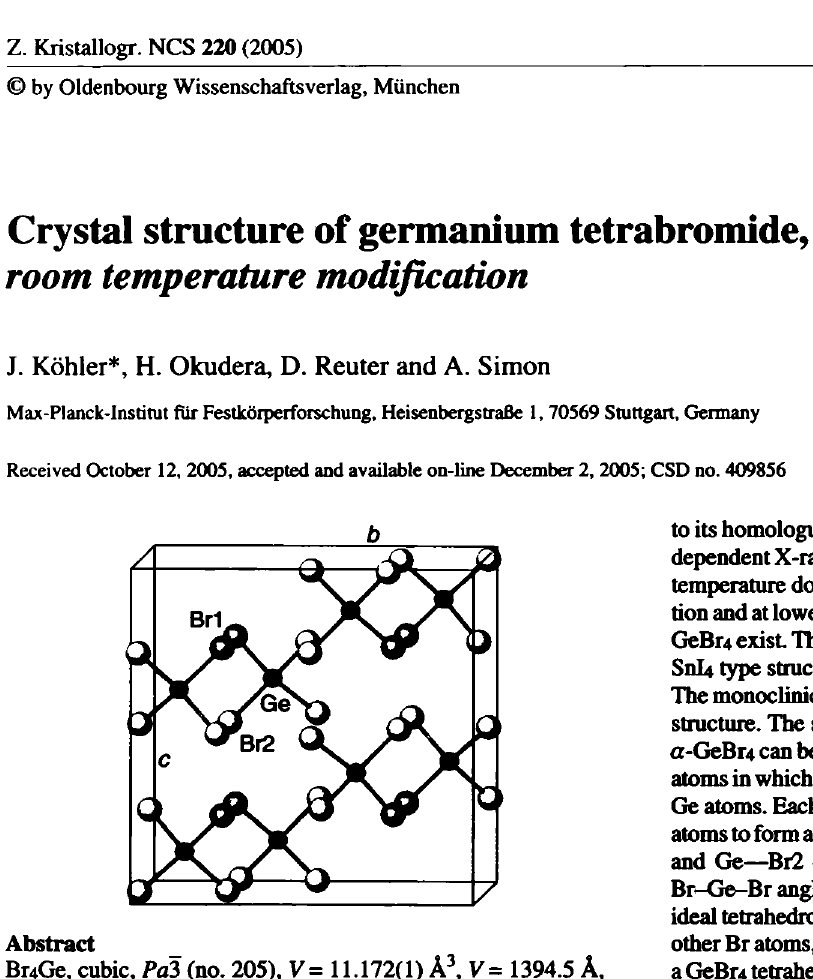
Table 1. Data collection and handling.